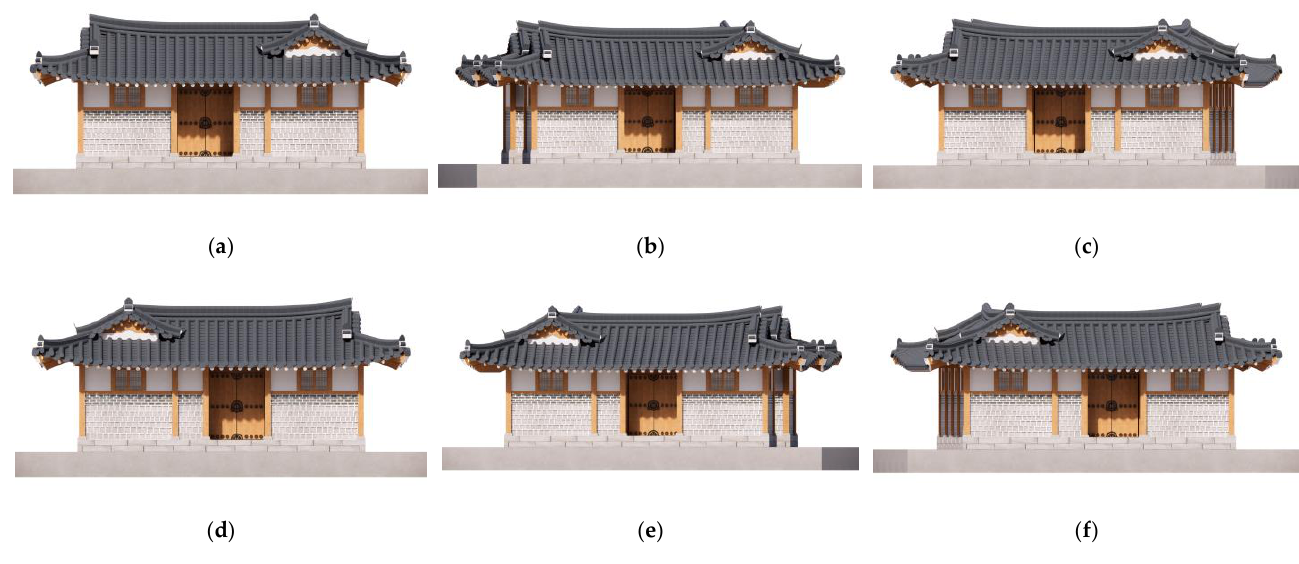
Figure 12. Data augmentation of facade images. ( a ) Front image, ( b ) left side image, ( c ) right side image, ( d ) flipped front image, ( e ) flipped left image, ( f ) flipped right image.